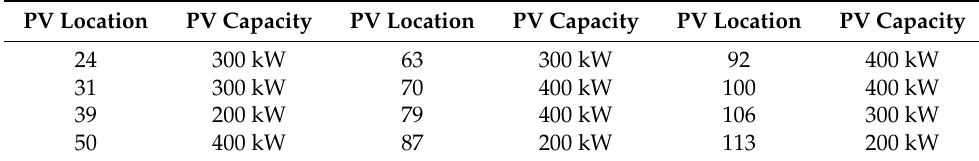
Figure 3. The modified IEEE 123-bus system topology. Table 1. The capacities and locations of 12 installed PV